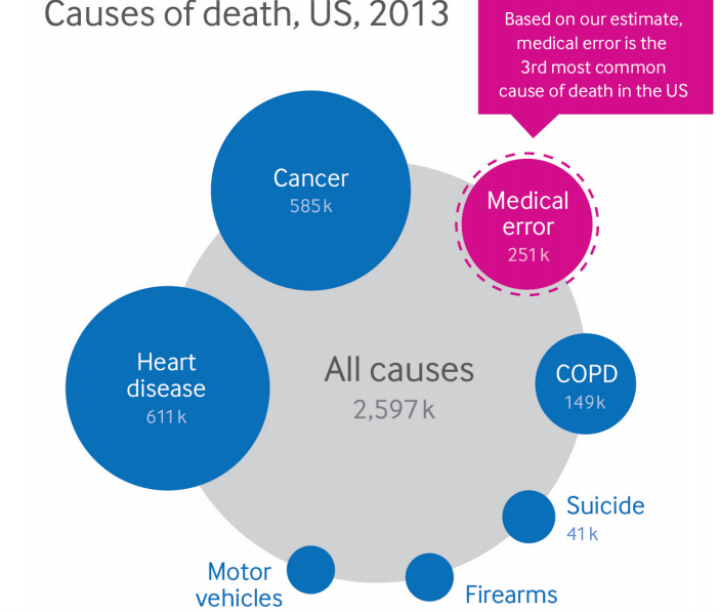
Fig. 1. Most common causes of death in the United States, 2013 (Martin and Michael